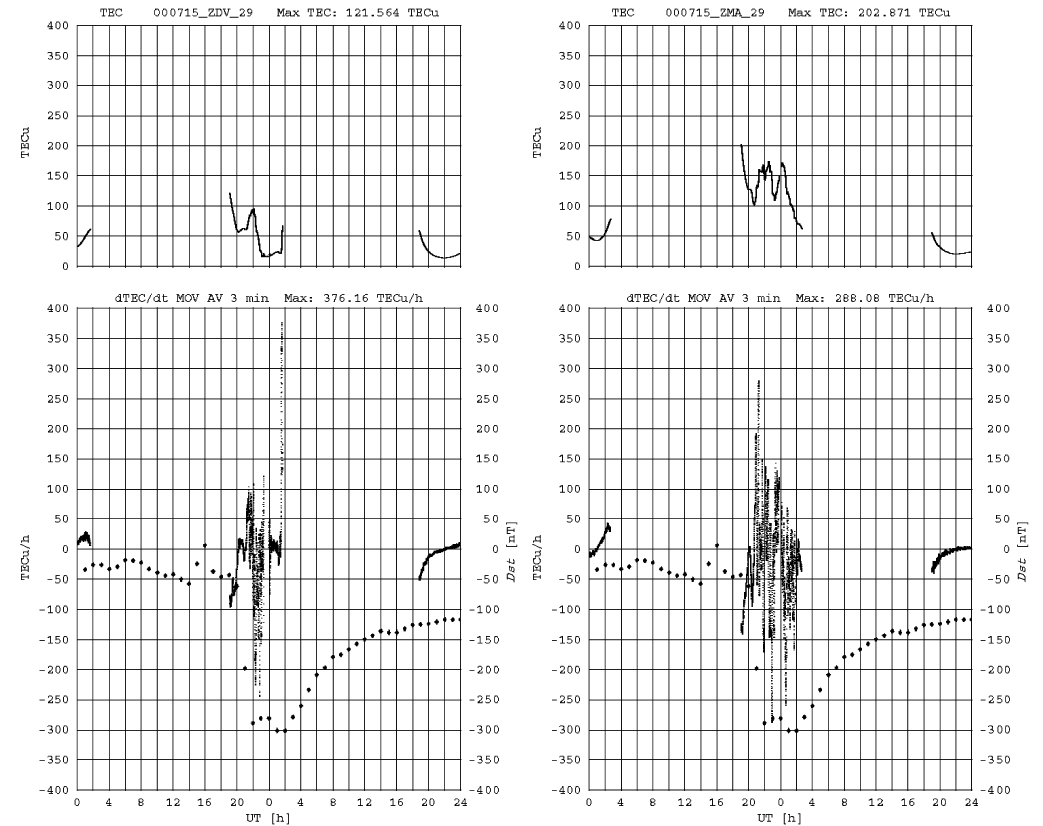
Fig. 18.8. sTEC, moving average (window length = 3 min) of sTEC rate of change, satellite elevation and azimuth as a function of UT for July 15-16. Left panels refers to the link: Denver station (40.2°N, 254.9°E), PRN 29. Right pan- els refers to the link: Miami station (25.8°N, 279.7°E), PRN 29. Dst index values are also indicated (black